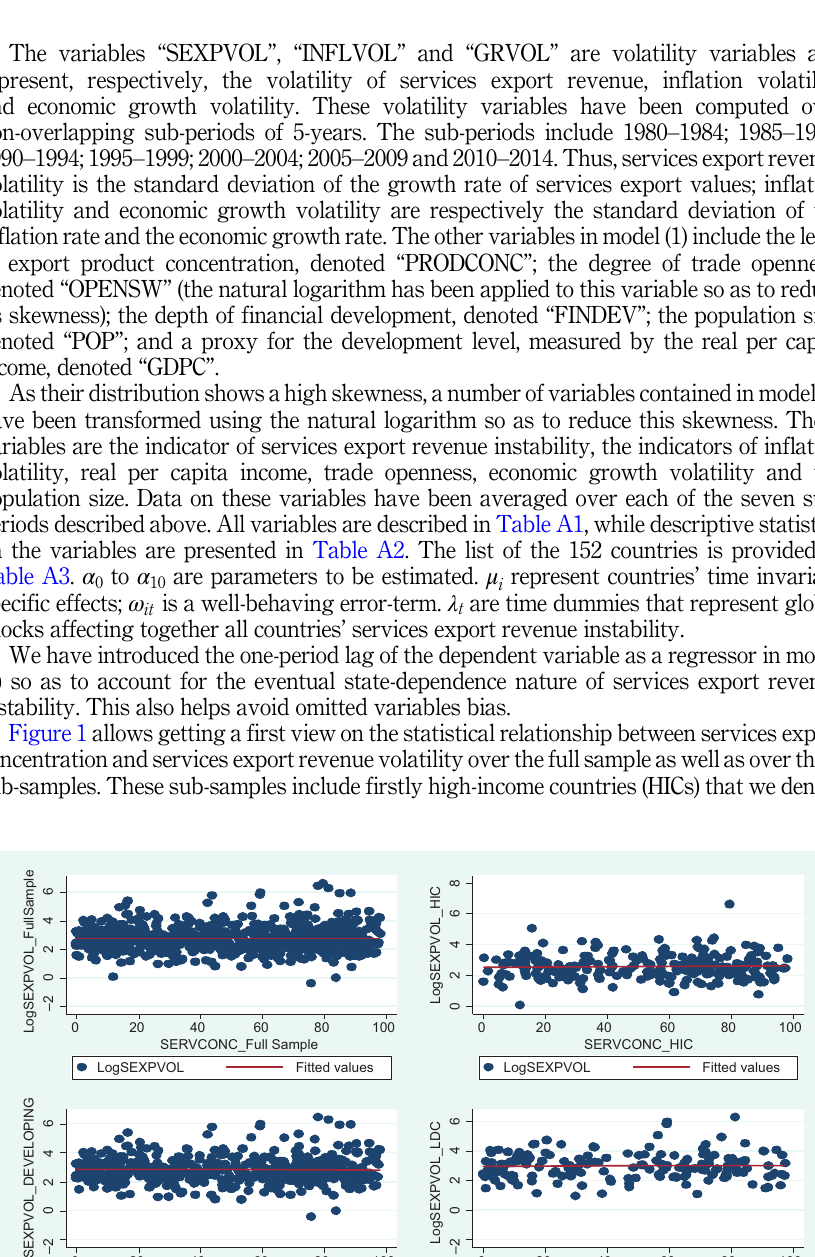
Figure 1. Correlation pattern between SERVCONC and